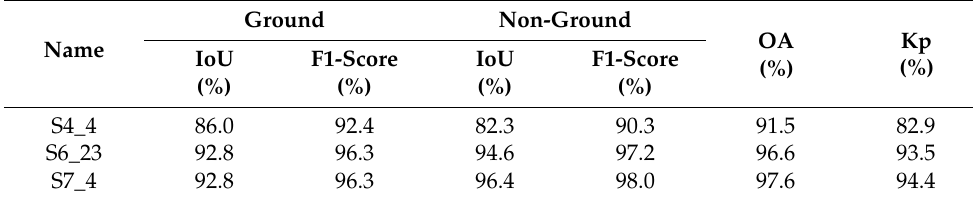
Table 3. Ground filtering results on third-party public